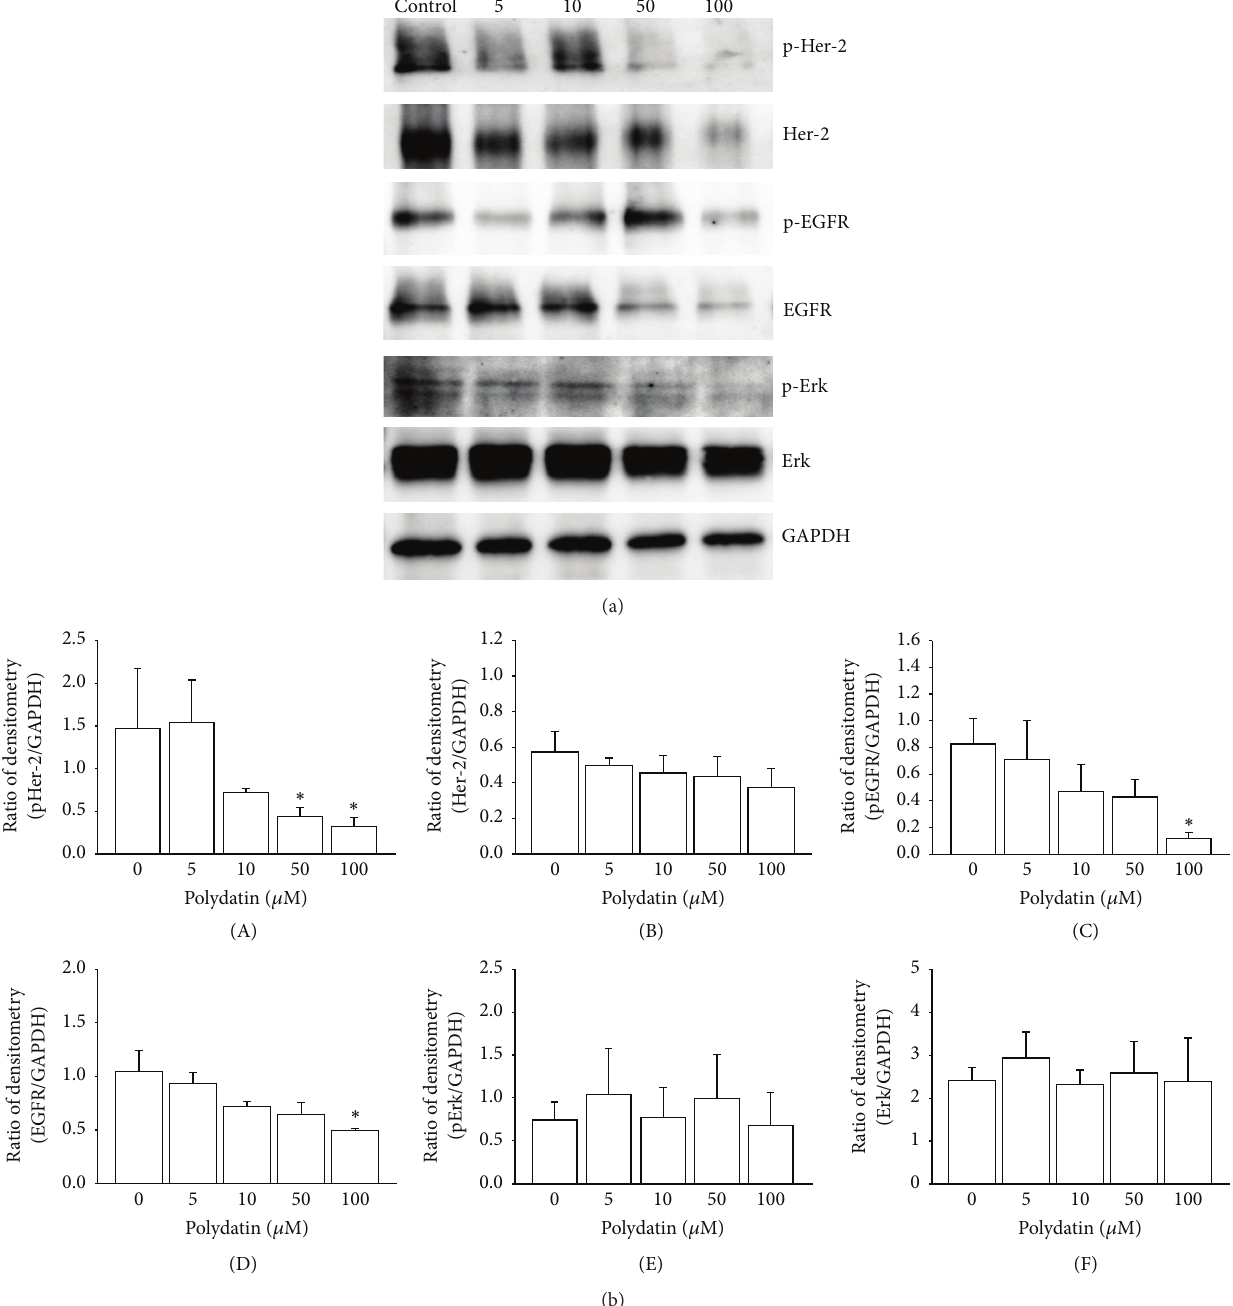
Figure 6: In SKOV-3 cell aggregates, the phosphorylation of Her-2 (A) and EGFR (B) was significantly reduced at higher concentrations of polydatin. The total expression of EGFR was significantly reduced with 100 𝜇 M polydatin (D). There was no effect on Erk1/2 (E). ∗ refers to statistically significant as 𝑝 value less than 0.05 compared to the